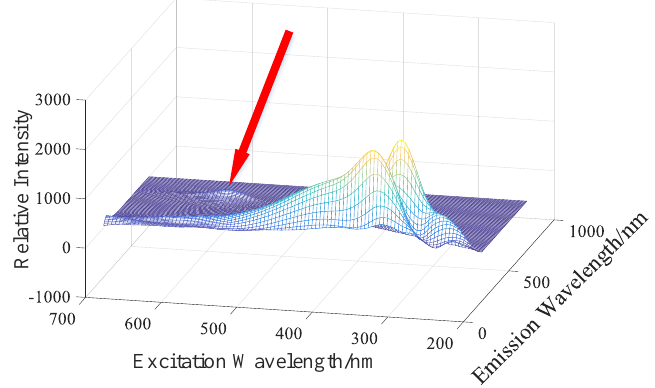
Figure 5. Spectral images of 2 μg/L rhodamine B.